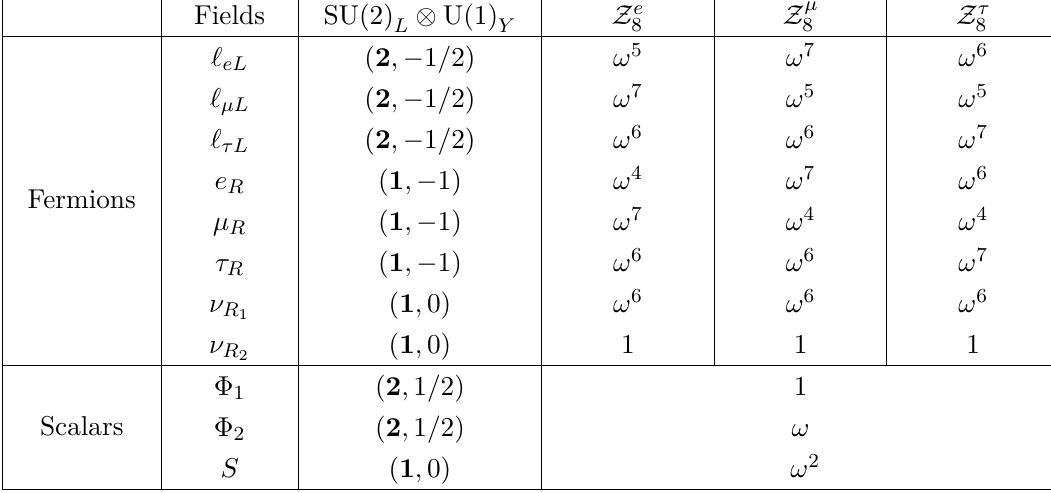
Table 1 . Field content of the model and corresponding transformation properties under the SU(2) gauge group. For the Z ⊗ U(1) L Y